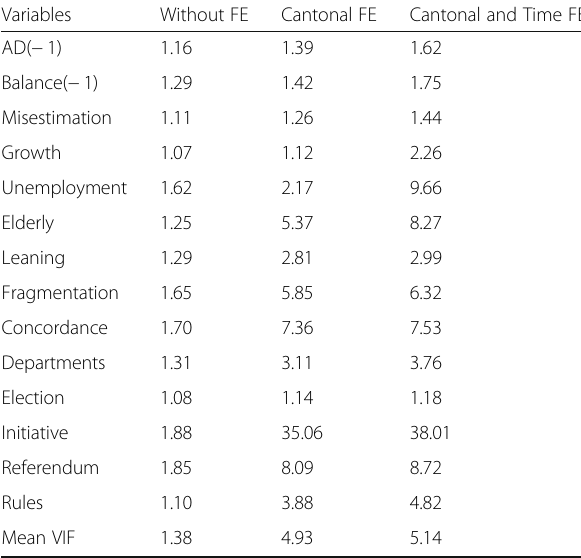
Table 12 Variance inflation factor (VIF) for the regressors